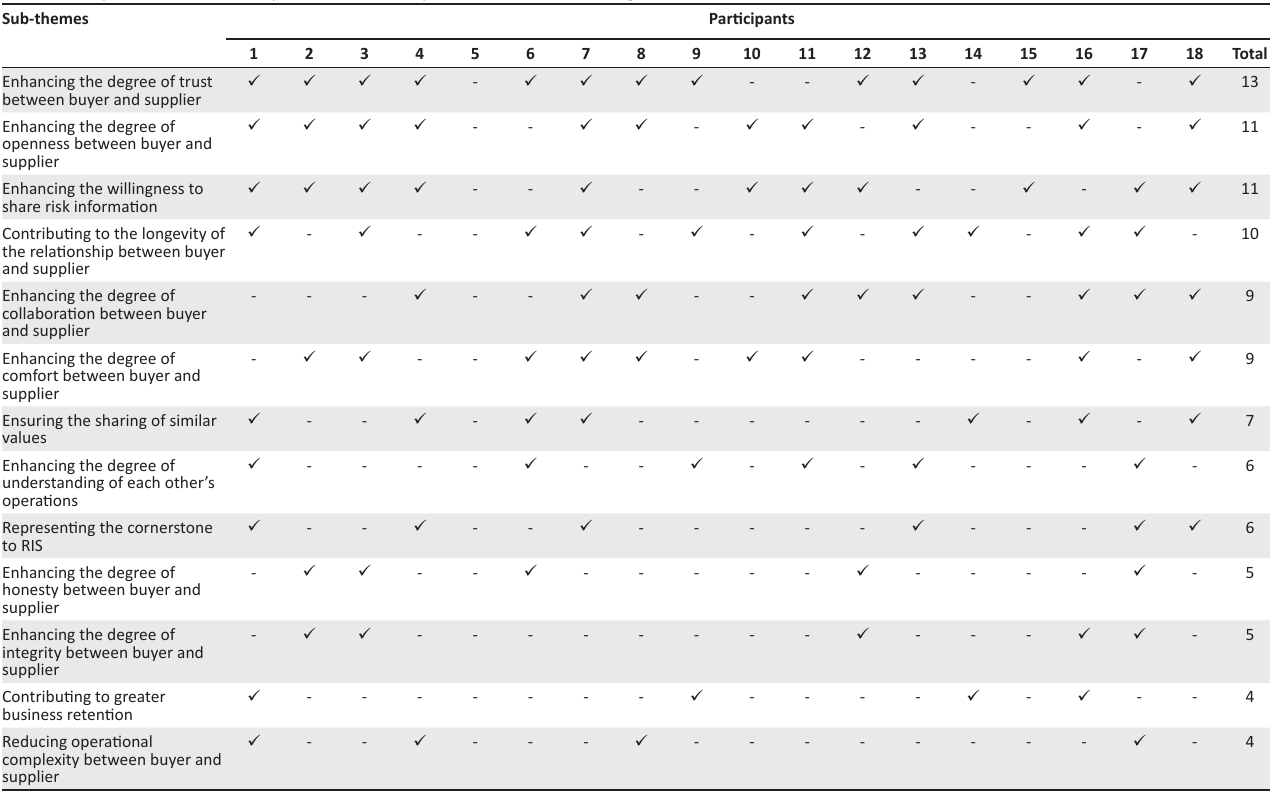
TABLE 2: Frequencies of the role of personal relationship in risk information sharing.